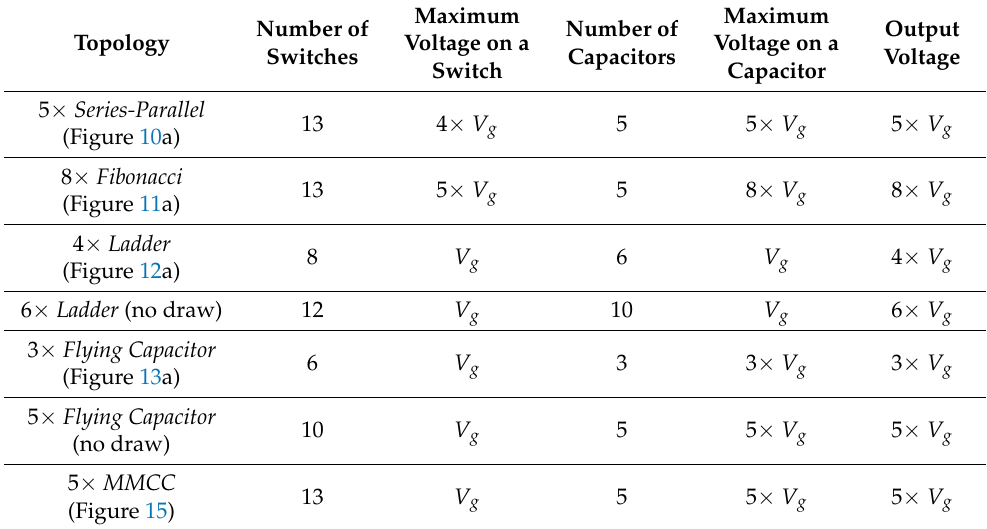
Table 1. Comparison between transistorized pure switched-capacitor